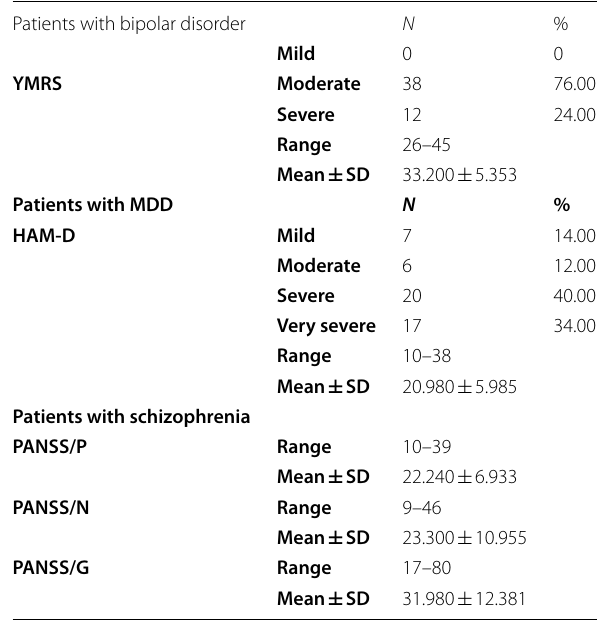
Hamilton depression scale, SD Standard deviation